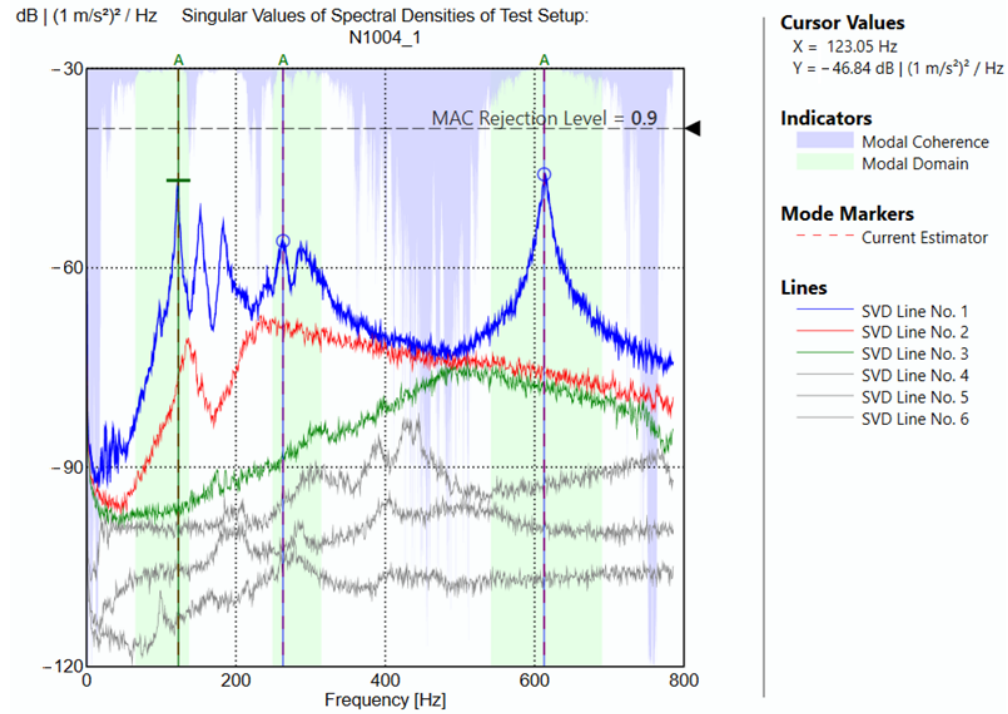
Figure 5. Singular values of spectral densities for one of the specimens without defects in timber ‐ to ‐ concrete connection.